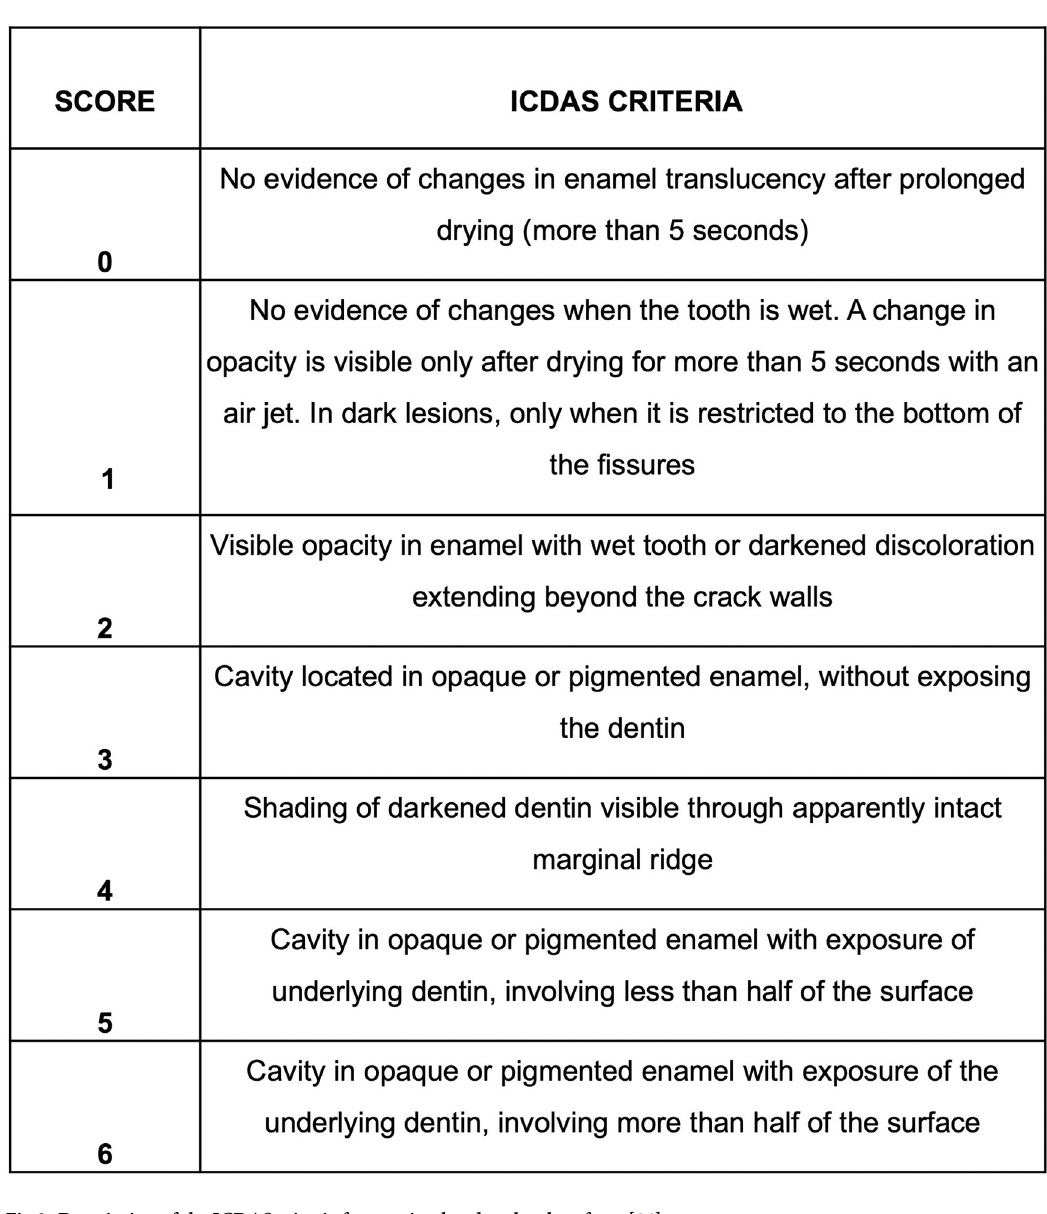
Fig 2. Description of the ICDAS criteria for proximal and occlusal surfaces